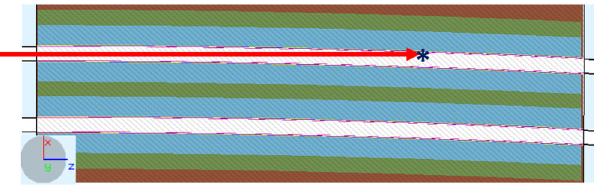
FIG. 14. Schematic trajectory of high-energy neutral particles coming straight from the LSS and crossing, at the indicated point, the boundary of the B1 mechanical aperture of the first DS main